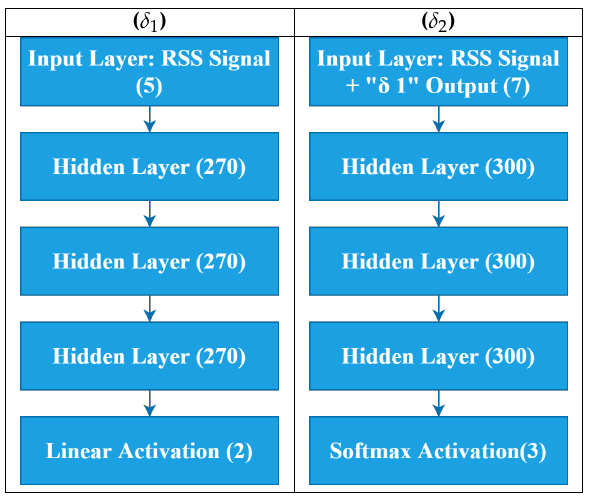
Figure 6. RSS Values Measured vs. TruNET Kanaris et al. [42].